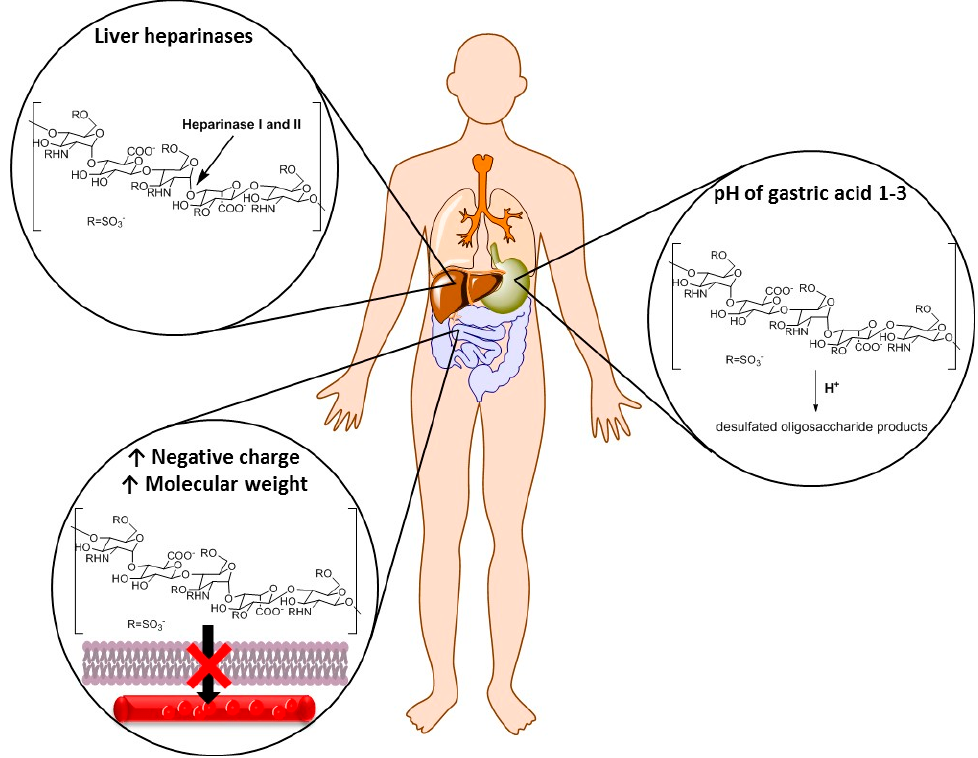
Figure 1. Structural features of heparins that limit their oral bioavailability. UFH—Unfractioned heparin.